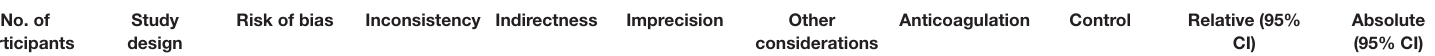
TABLE 3 | GRADE quality assessment. Certainty assessment No. of